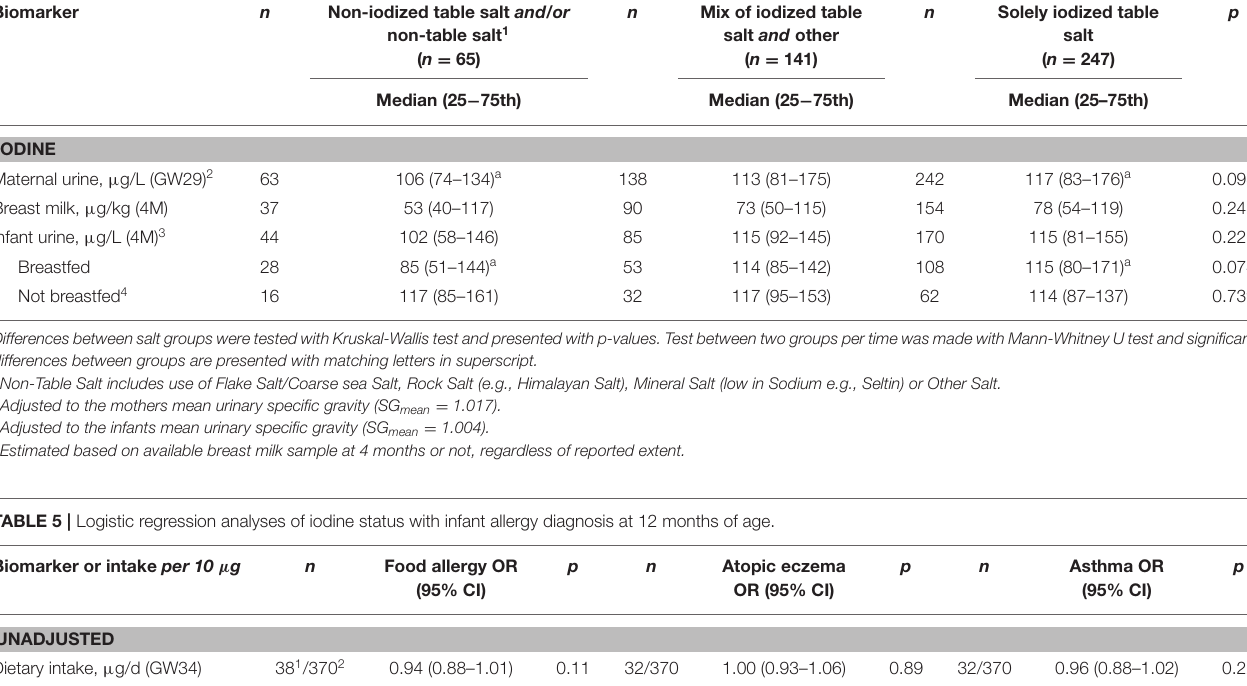
TABLE 4 | Biomarker iodine concentrations in gestational week 29 (GW29) and at 4 months postpartum (4M) grouped by the use of iodized table salt. Biomarker n Non-iodized table salt and/or non-table salt 1